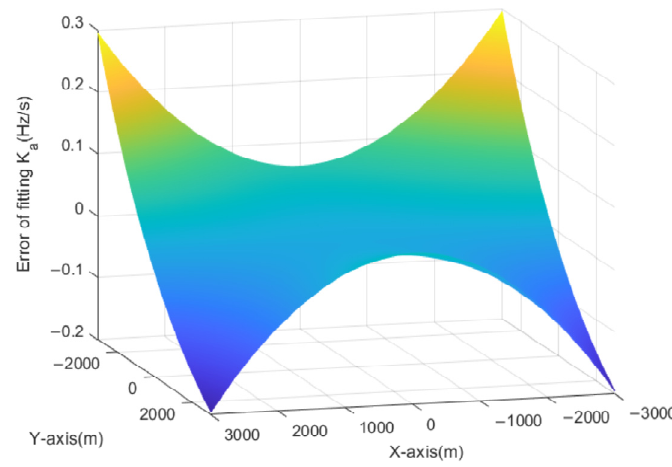
Figure 11. The error of _ a fit K in the scene.